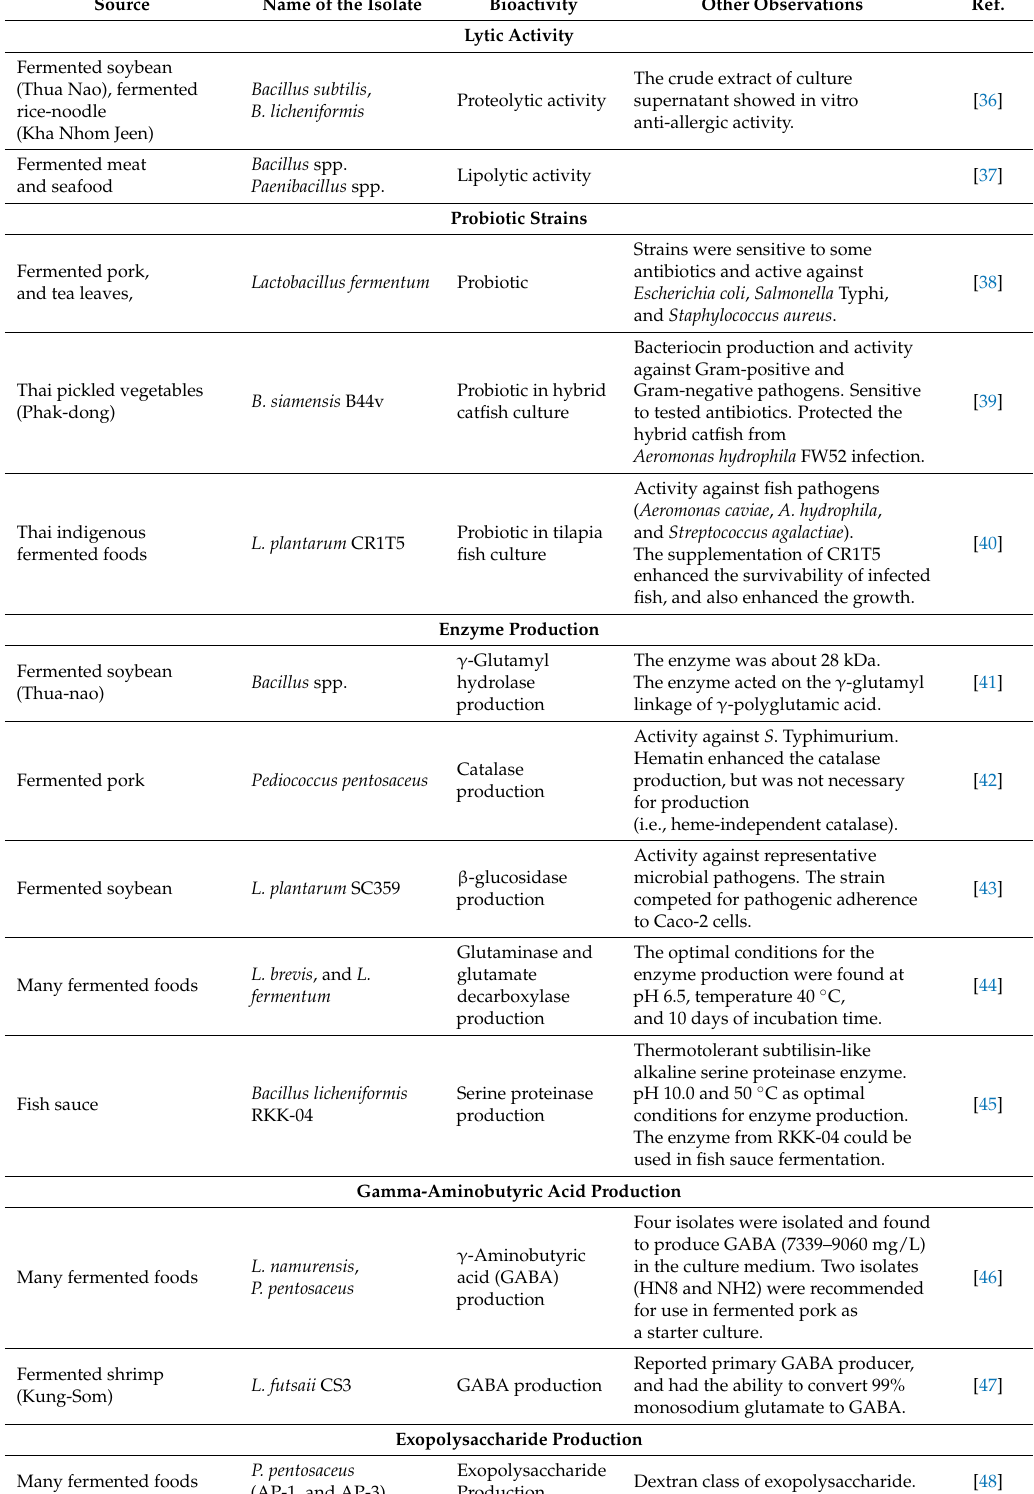
Table 2. Functional properties of lactic-acid bacteria isolated from Thai fermented